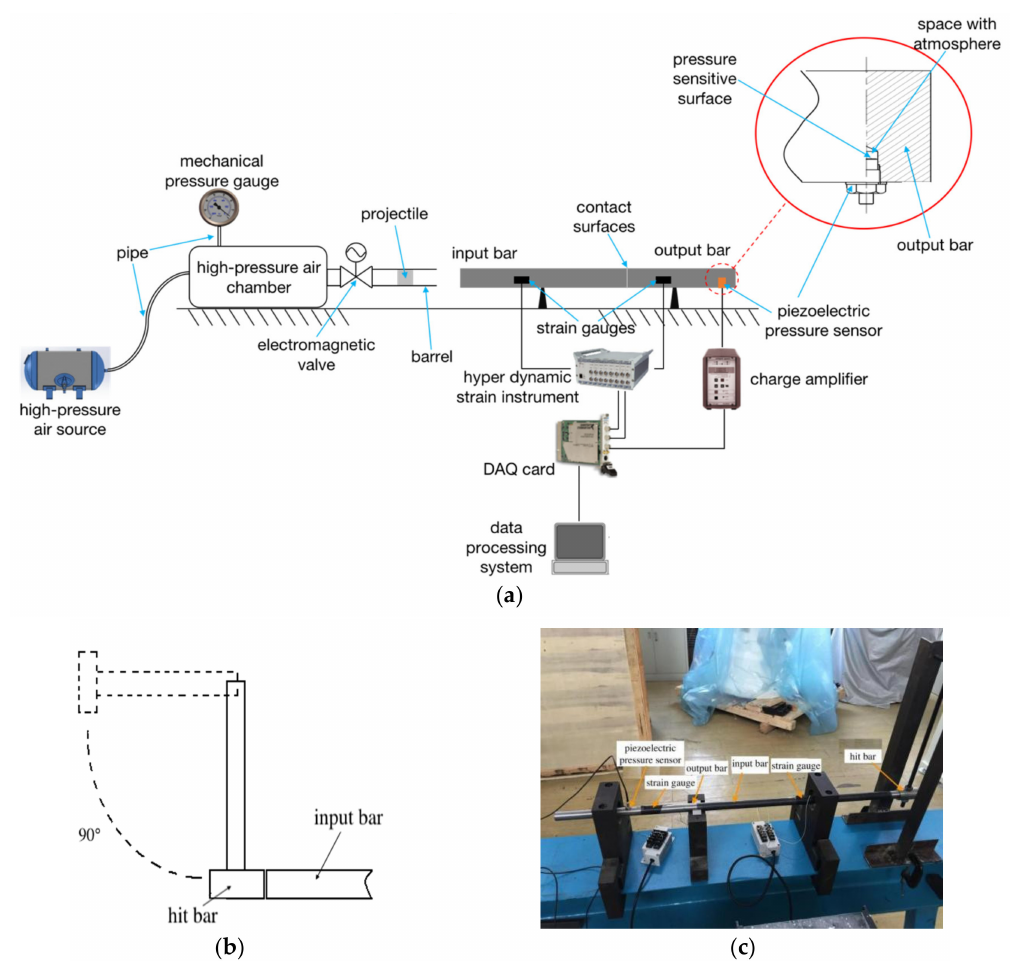
Figure 2. The split Hopkinson pressure bar (SHPB) test equipment. ( a ) Structural schematic diagram. ( b ) Loading way of stress wave. ( c ) Photograph of the